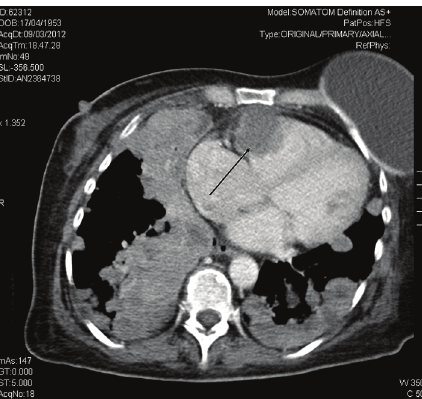
Figure 5: Mass involving right ventricular sections. Chest high- resolution computed tomography pulmonary angiography showing mass pertaining to the pericardium with intracardiac extension at level of anterior right ventricle wall causing occlusion of tricuspid valve